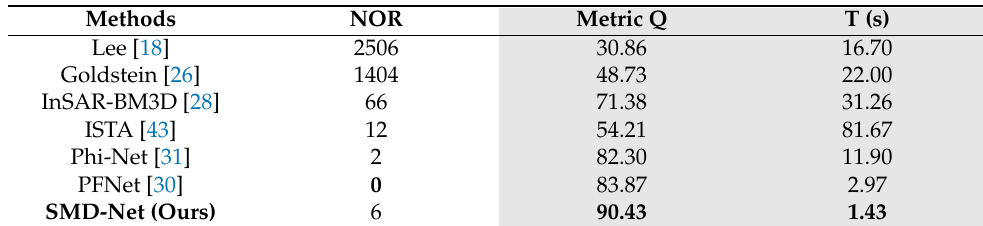
Table 2. The metrics of the seven methods on the measured interferogram of area A. Metric Q is the core accuracy index. T is the speed